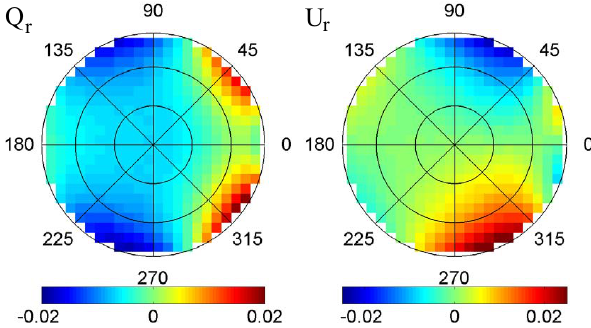
Fig. 2. Rotated Stokes maps Q r and U r from model calculations for 650nm, SZA = 60 ◦ and urban aerosol type a (Greenbelt, USA) with AOD = 0.23.